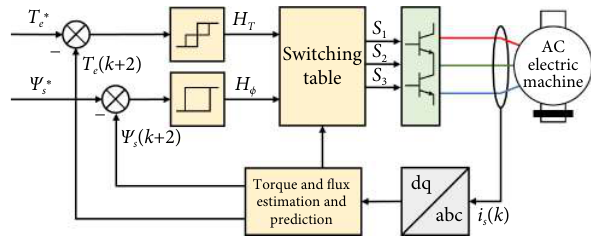
Fig. 24 Control scheme diagrams of DTC.